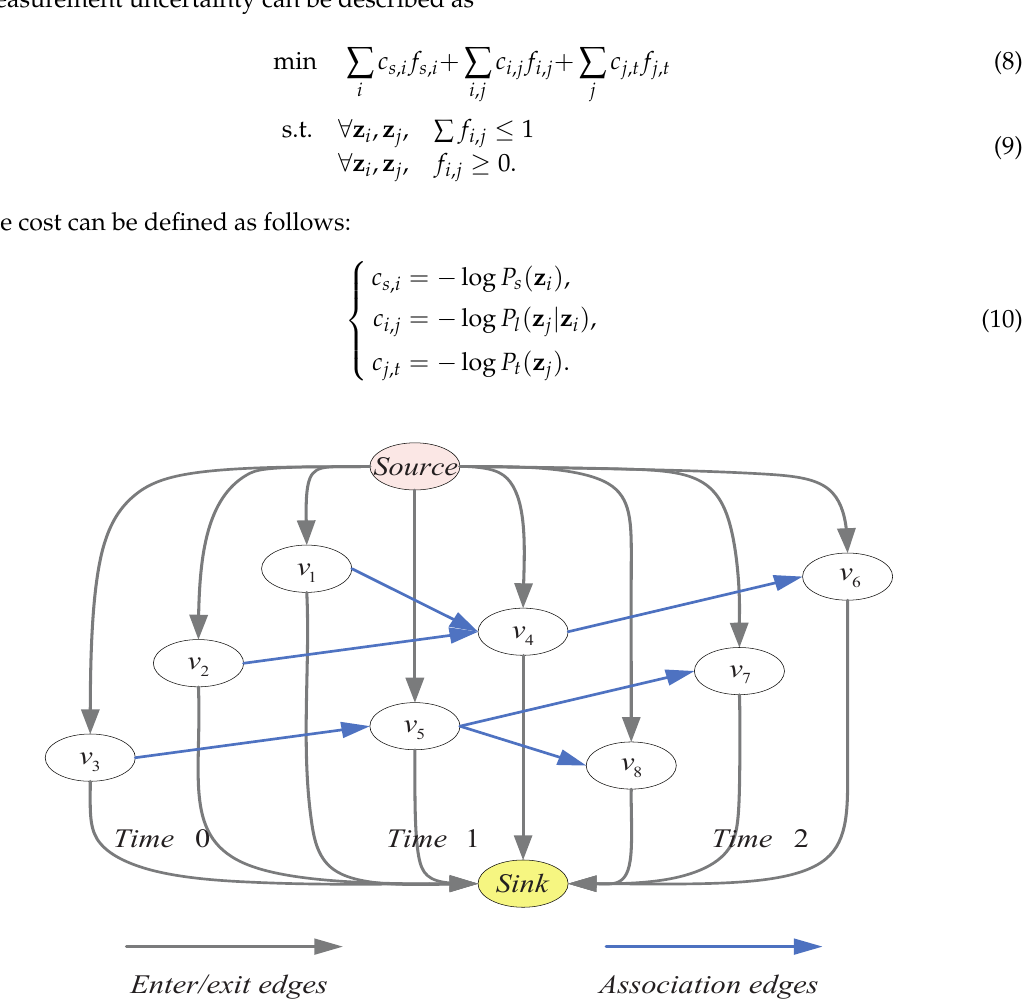
Figure 1. An example of cost flow model with three time